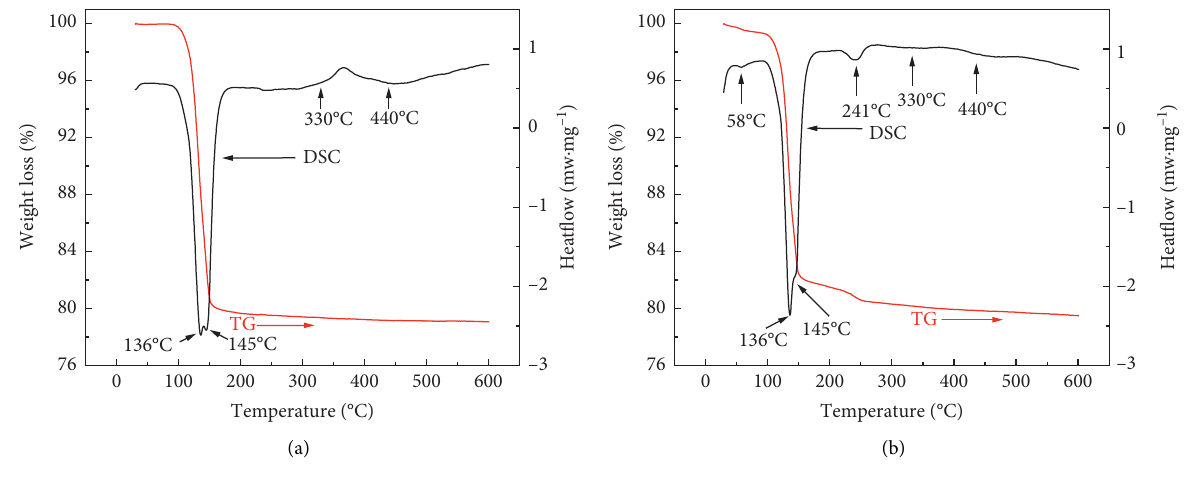
Figure 5: DSC/TG curves of hardened RP (a) and hardened RAP